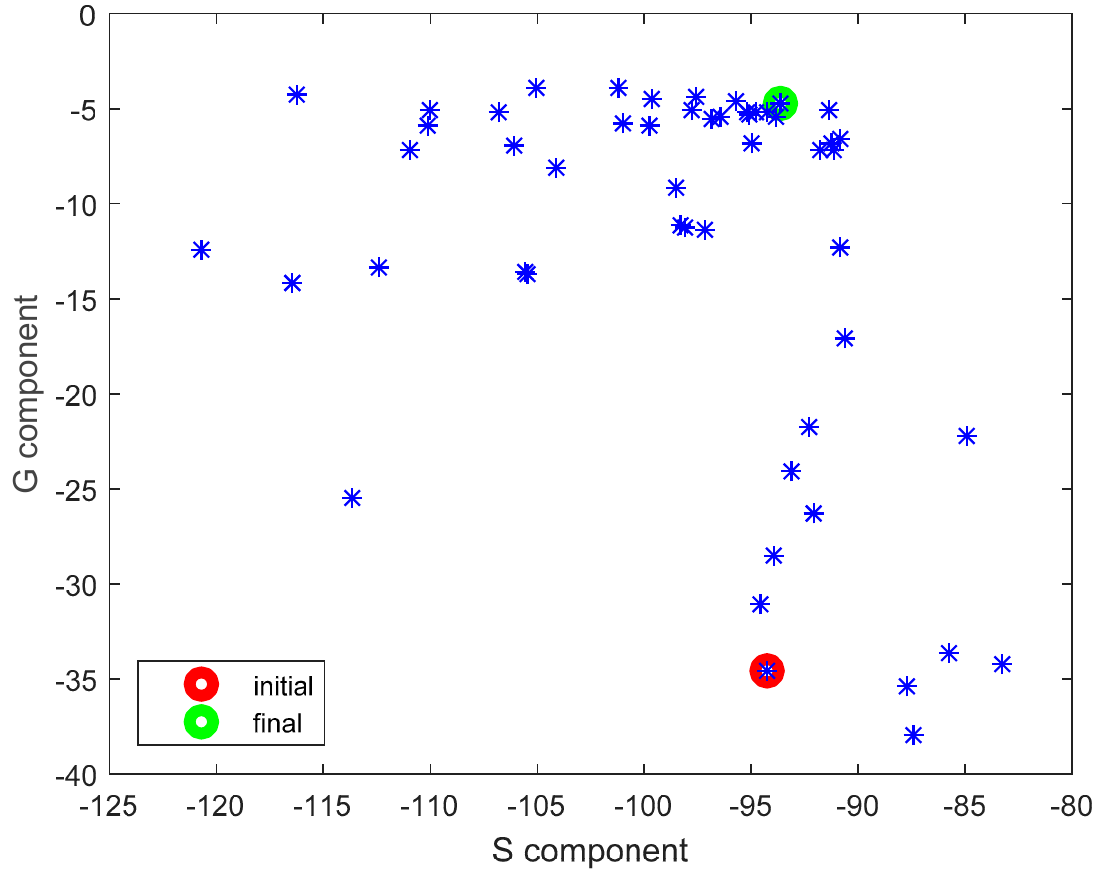
Figure 19. The history of the optimization process (2 nd case) in the objective function space.